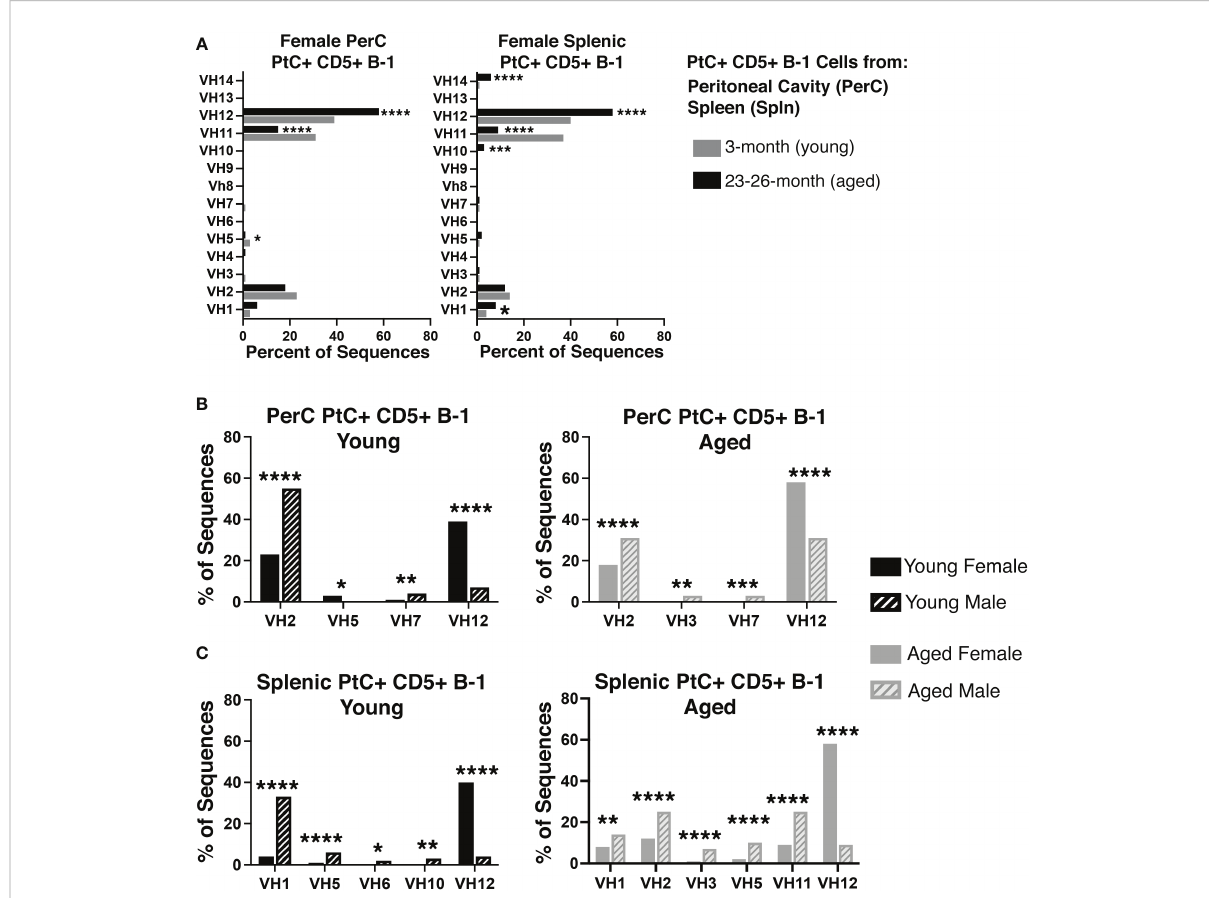
FIGURE 2 Repertoire analysis of natural IgM from peritoneal and splenic PtC+ CD5+ B-1 cells in adult female young and aged mice. PtC+CD5+ B-1 cells were single-cell sorted from the peritoneal cavity or spleen of 3- and 23-26-month-old female BALB/c-ByJ mice. The V H region was ampli fi ed and sequenced as detailed in Materials and Methods. (A) The percent of V H gene segment usage (young in grey bars, aged in black bars). (B, C) For direct comparison of females and males,previously published (24) repertoire analyses of young and aged male PtC+CD5+ B-1 cells is included. Results are based on 4 independent experiments with sequences combined from each independent experiment (n=11 for 3-month- old mice, n=15 for 23-26-month-old female mice). Statistics used: 2x2 chi-square test. Asterisks for p values: *p<0.05, **p<0.01, ***p<0.001,